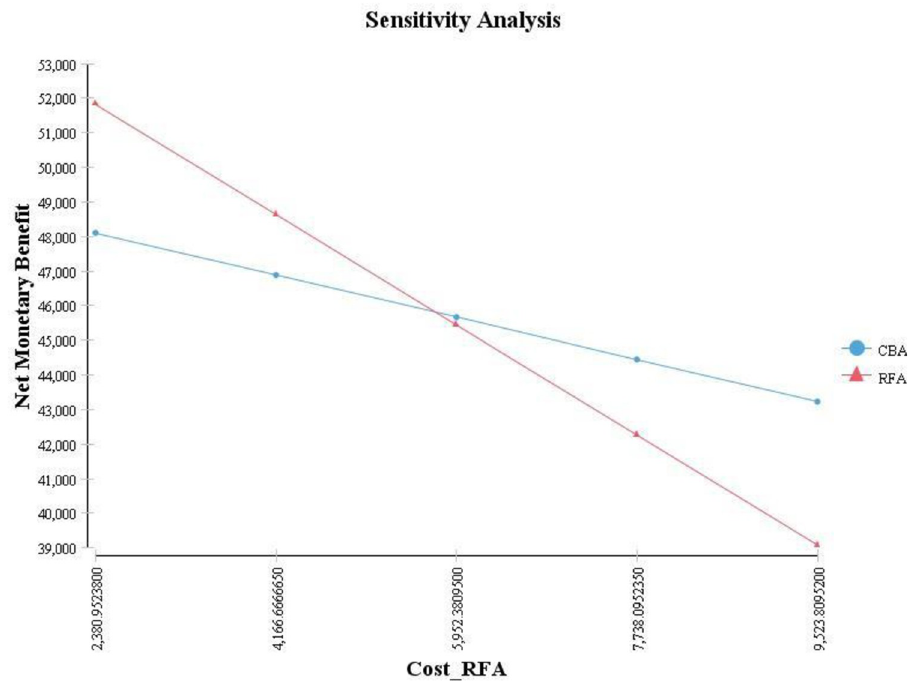
Fig 4. One way sensitivity analysis (RFA